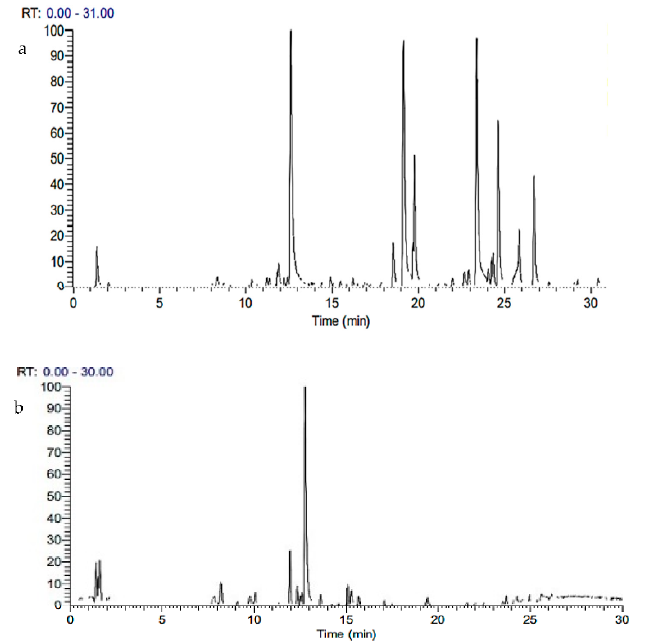
Figure 1. Chromatograms of the ethanolic extract ( a ) and ethanolic fraction ( b ) of Lepechinia meyenii (salvia).